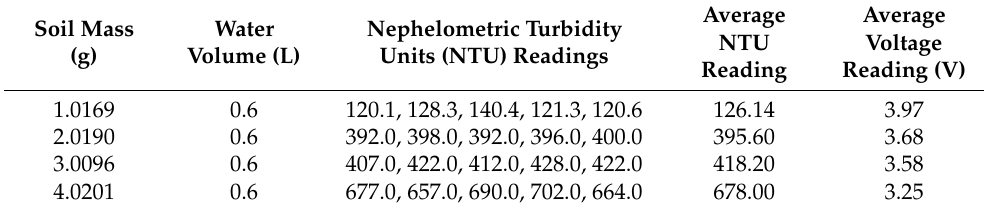
Table 2. Data for turbidity calibration.